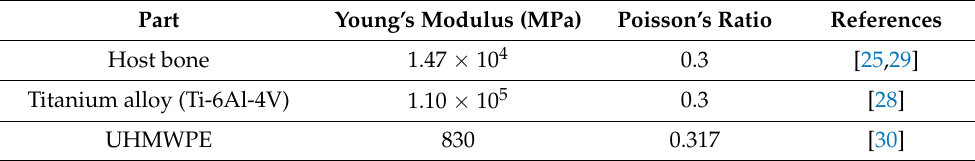
Table 3. Material properties for anatomical and prosthetic TMJ components.